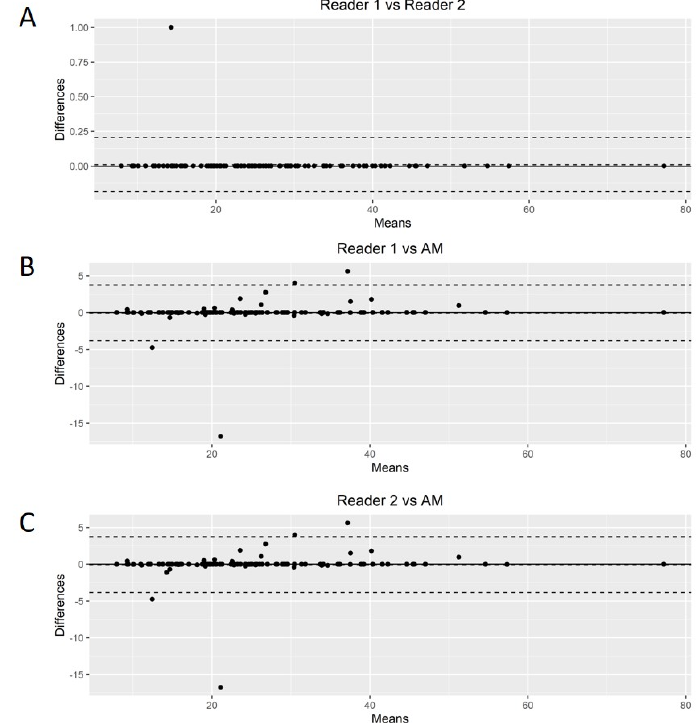
Figure 5. Bland–Altman plot. Graphical display for bias between two readers and automated method (AM) in SUVmax calculation ( A – C ). Subsequently, we calculated the Root-Mean-Squared Error (RMSE) between readers (average) and the proposed AM as a measure of accuracy and positive difference and negative difference between the two measurements as a bias. For MTV calculations, the RMSE was 54.7, with a positive bias of 28.4 and a negative bias of 0.27 (Supplemental Figure S1A). The mean difference between readers was 20.92 (95% limits of agreement of − 49.77 and 91.63). AM demonstrated smaller MTV values compared to those of the nuclear medicine readers. For SUVmax calculations, we found an RMSE of 1.93 with a positive bias of 15.4 and a negative bias of 1.26 (Supplemental Figure S1B). The mean difference between readers was − 0.03 (95% limits of agreement of − 3.34 and 3.26). Again, AM demon- strated smaller values of SUVmax compared to the nuclear medicine readers.